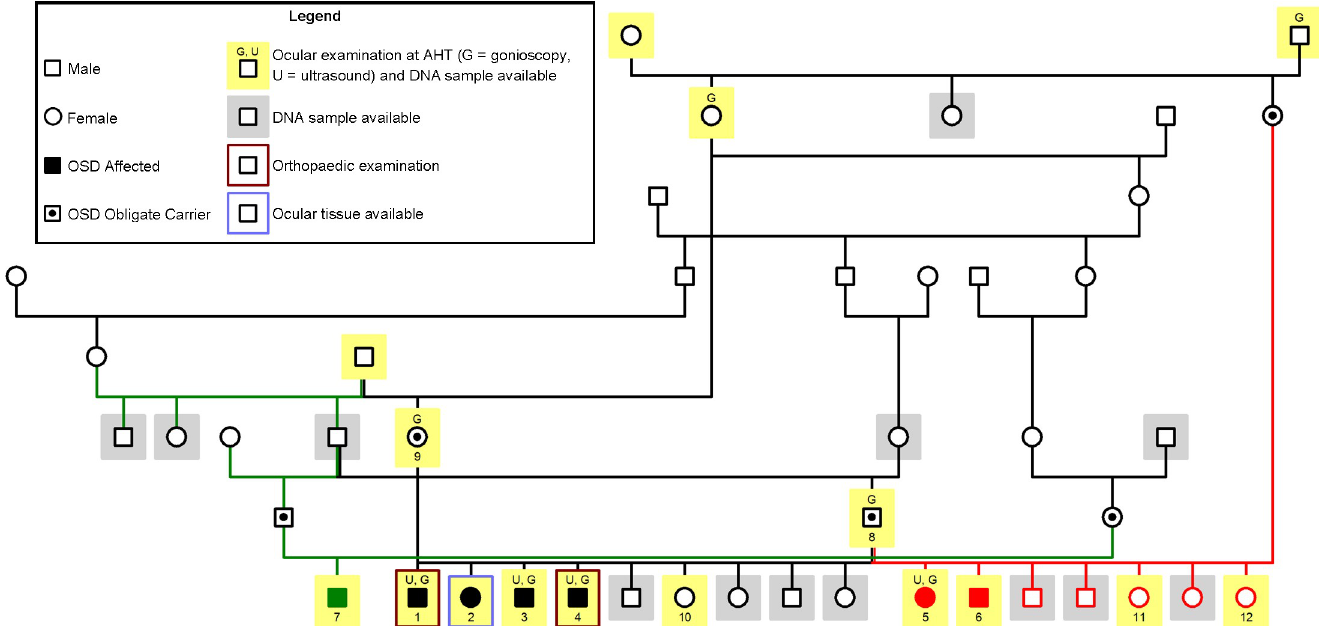
Fig 1. Pedigree of oculoskeletal dysplasia (OSD)-affected and related Northern Inuit Dogs (NID). OSD-affected and obligate carriers (sires and dams of OSD- affected NID), dogs that underwent ocular examination (including gonioscopy and ultrasound examinations where applicable), orthopaedic examination and the dog (s) from which DNA or ocular tissue were available, are indicated as in the legend. Coloured lines are used for better visualisation of breeding pairs. All OSD-affected NID are closely related and segregation of OSD is consistent with an autosomal recessive mode of inheritance.